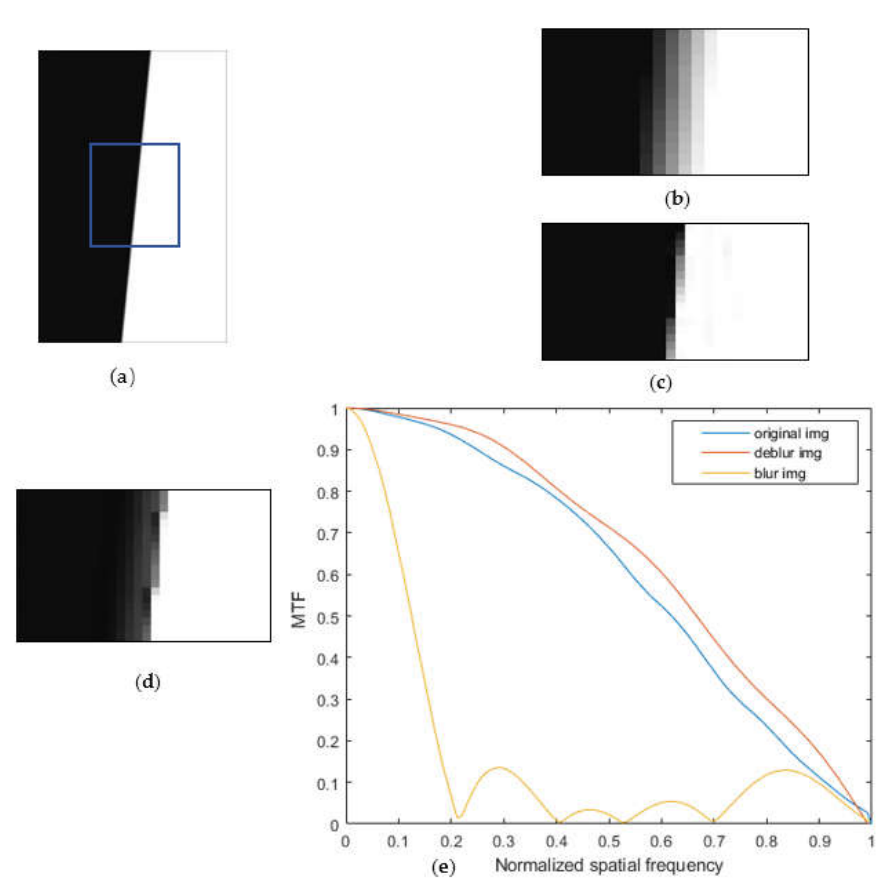
Figure 10. Edge image restoration results: ( a ) blurred image; ( b ) enlarged blurred image; ( c ) original image; ( d ) enlarged results; and ( e ) MTF comparison.